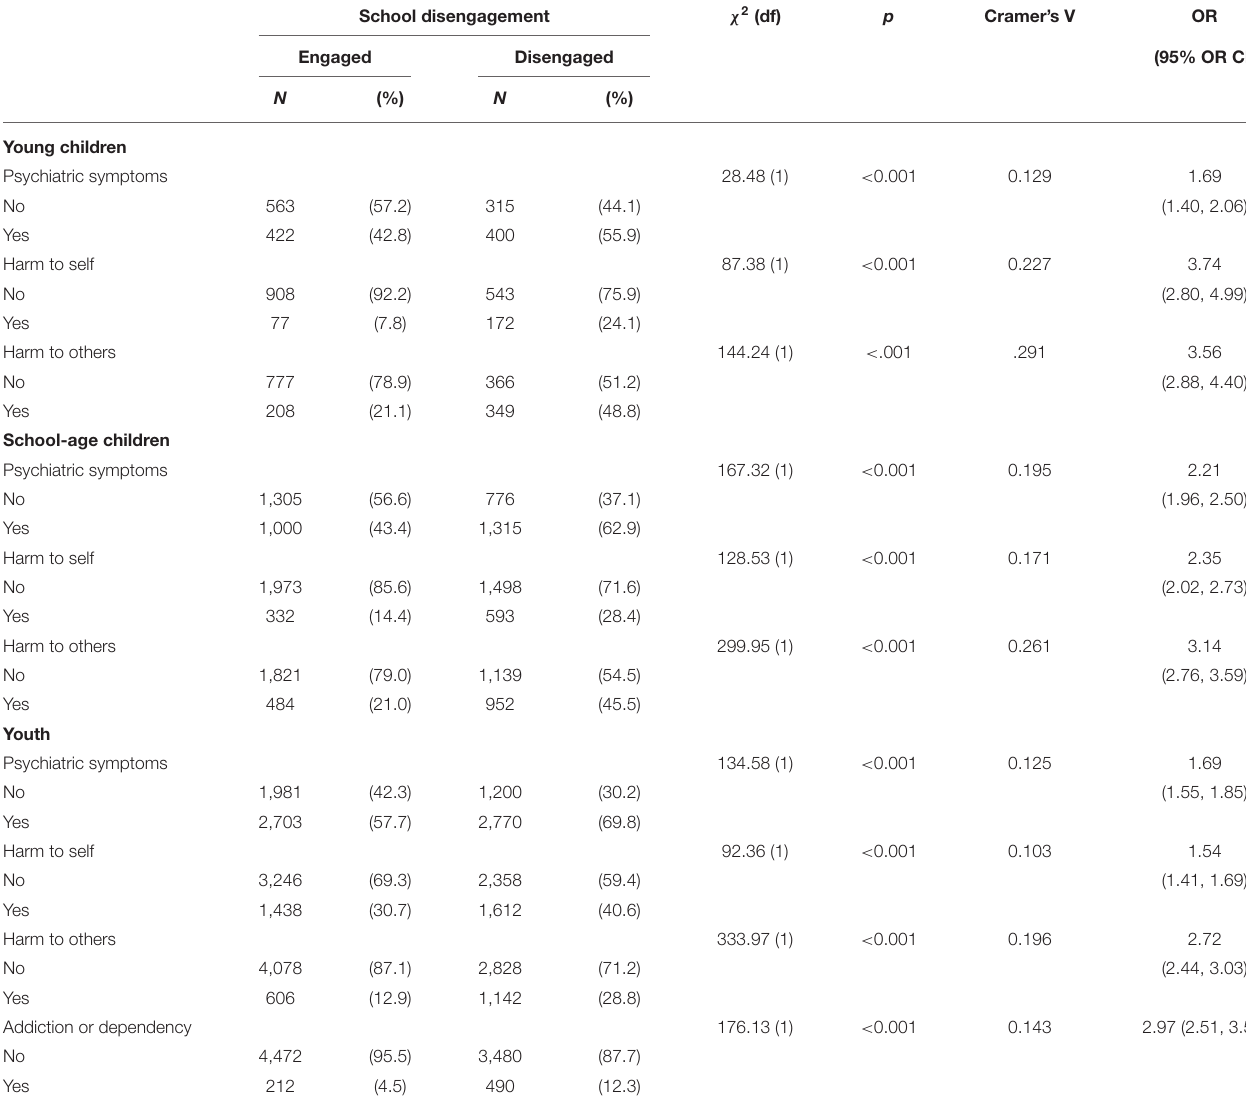
TABLE 3 | Chi-square comparison for school disengagement and reason for referral. School